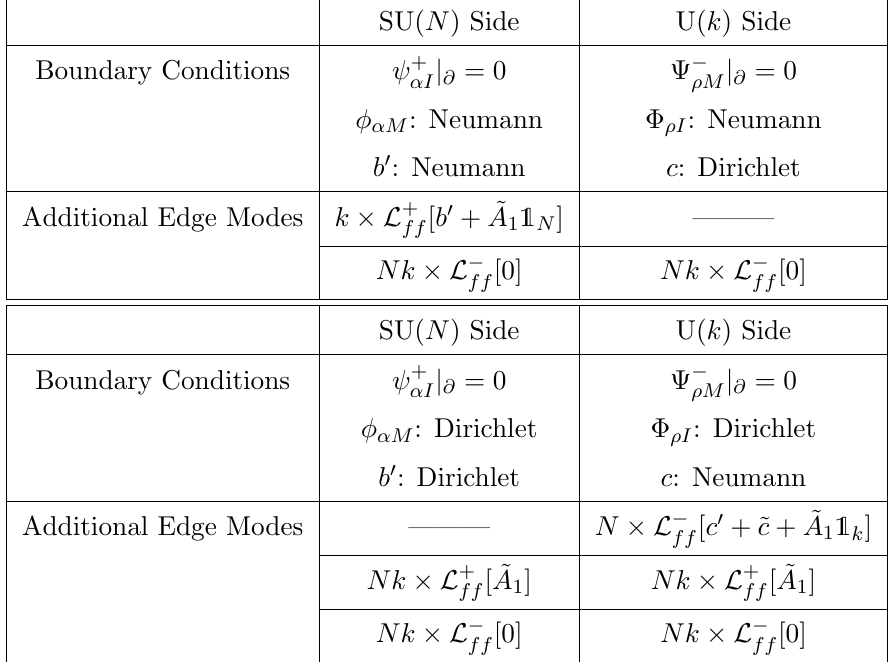
Table 5 . The top (bottom) table counts the additional edge modes when choosing Neumann and Dirichlet boundary conditions on the dynamical gauge (cid:12)elds in SU (U) and U (SU) side respectively when N f 6 = 0 and N s 6 = 0 for the time-reversed master